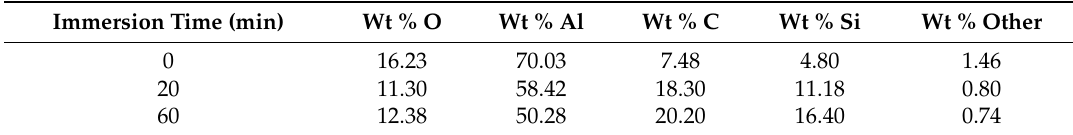
Table 5. EDS analysis of the aluminum substrate surface.